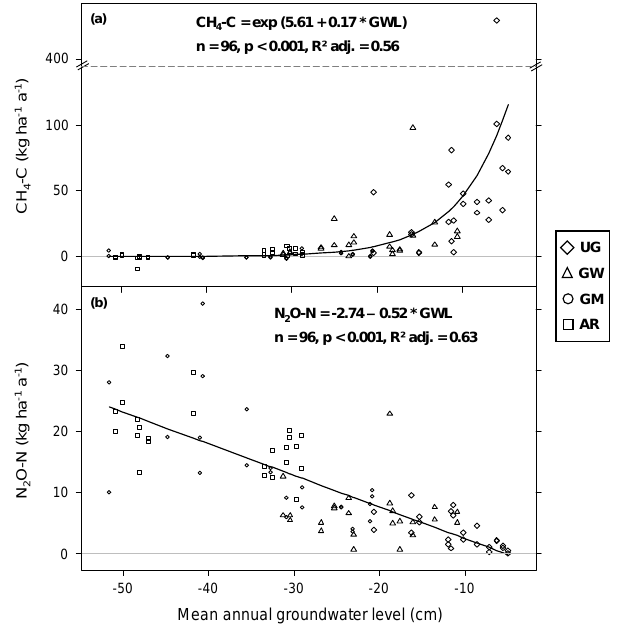
Figure 10. Relationships of cumulated annual CH 4 (a) and N 2 O fluxes (b) to mean annual groundwater level for the study period (April 2011–March 2014) with n = 8 per site and year. GWL in the equations is the mean annual groundwater level (cm). R 2 adjusted for exponential regression (a) was estimated for predicted vs. ob- tained values. Note the broken y axis for figure (a)